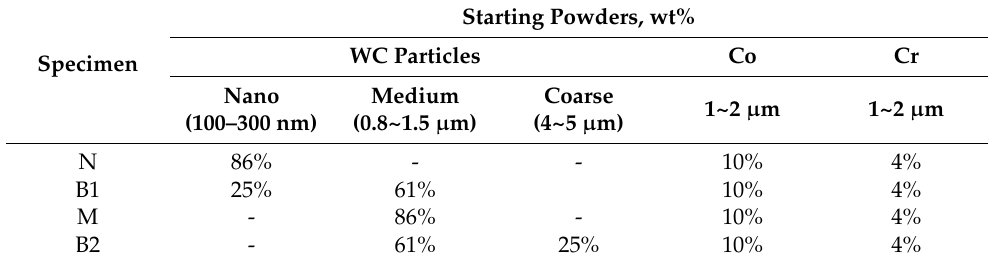
Table 1. Information on WC–10Co–4Cr spraying feedstock powders.